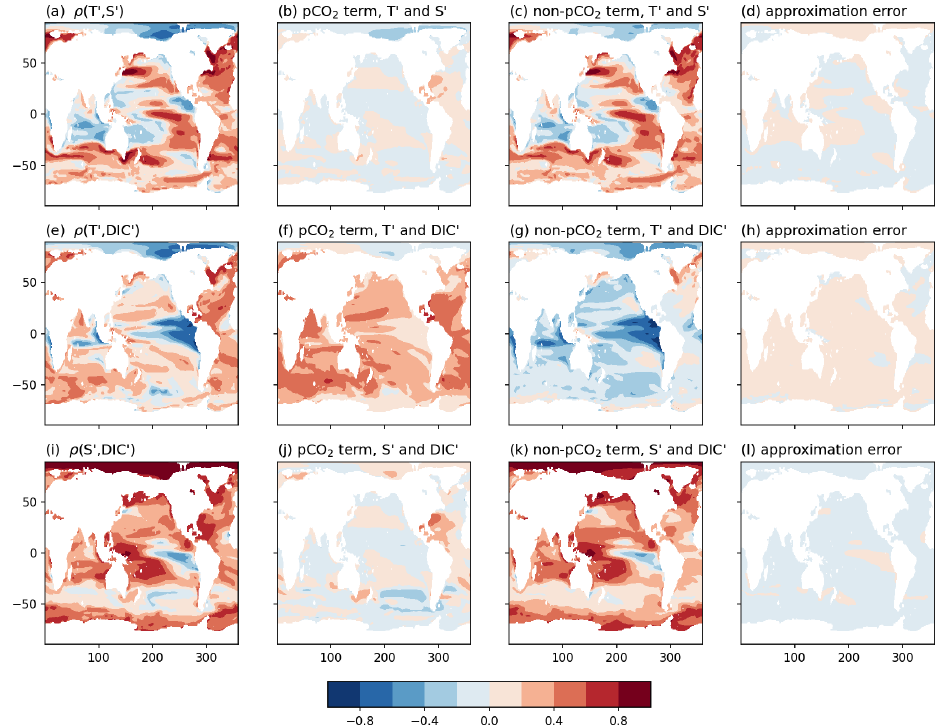
Figure A1. Correlation fields between non- p CO 2 variables T (cid:48) , S (cid:48) , and DIC (cid:48) , with their terms from Eq. (A5) and approximation errors to measure the level of mismatch between Eqs. (A4) and